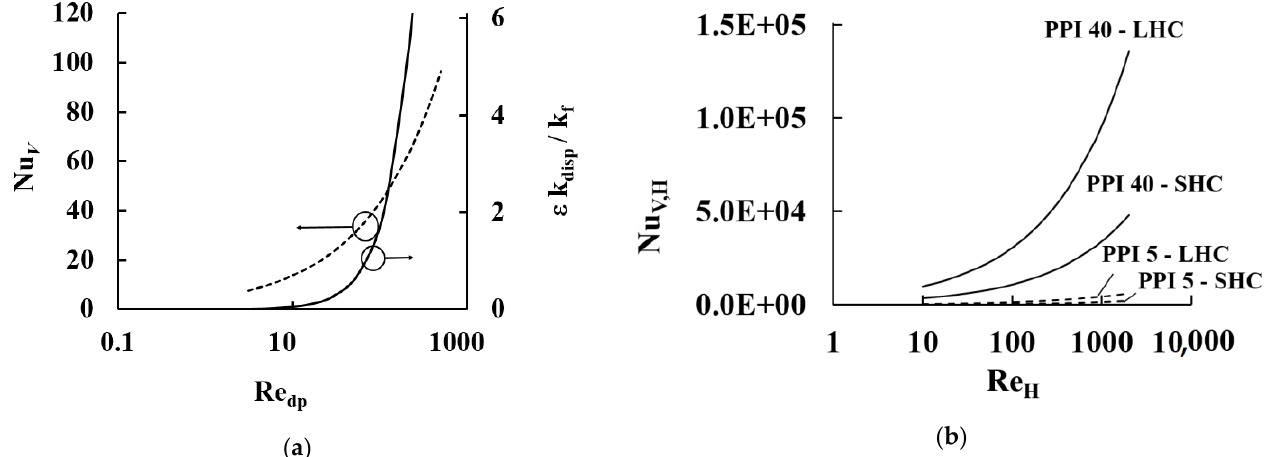
Figure 5. The change of pore-scale transport properties with Reynolds number, ( a ) the interfacial Nusselt number thermal dispersion ratio with pore-scale Reynolds number, ( b ) the channel-based Interfacial Nusselt number with channel-based Reynolds number.